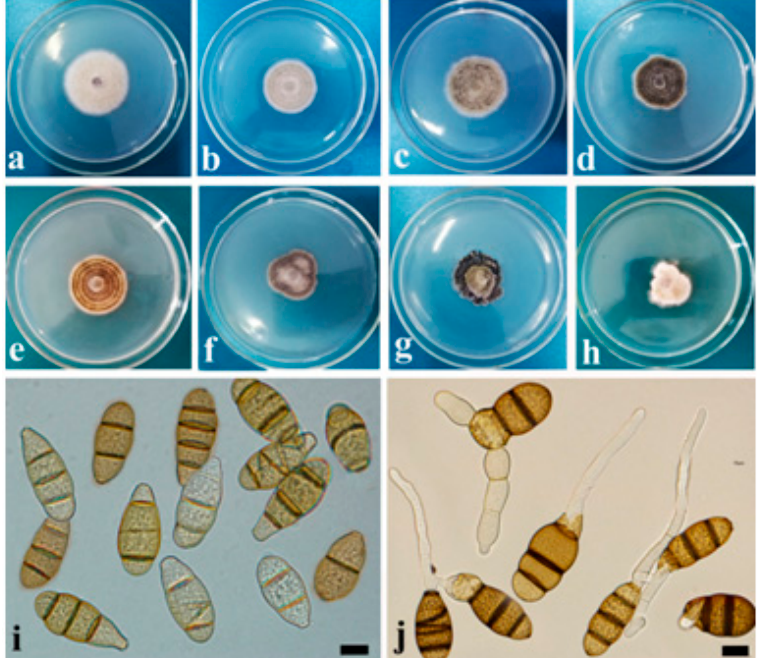
Figure 2. Colonies of Wilsonomyces carpophilus isolates and conidia characteristics: ( a – h ) Groups I to VIII of the culture ( a–e : 10 d; f–h : 18 d); ( i ) conidia; ( j ) germinated spores. Scale bars: i, j = 10 µm. Three isolates obtained from P. divaricata fruits were classified into the morphological Group